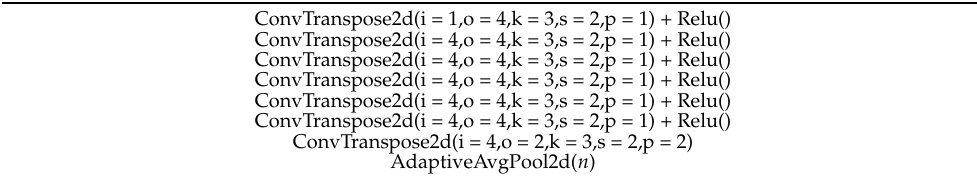
Table A6. HyperNN architecture parameters for Helmholtz equation. Notations in ConvTranspose2d are: i: in channels; o: out channels; k: kernel size; s: stride; p: